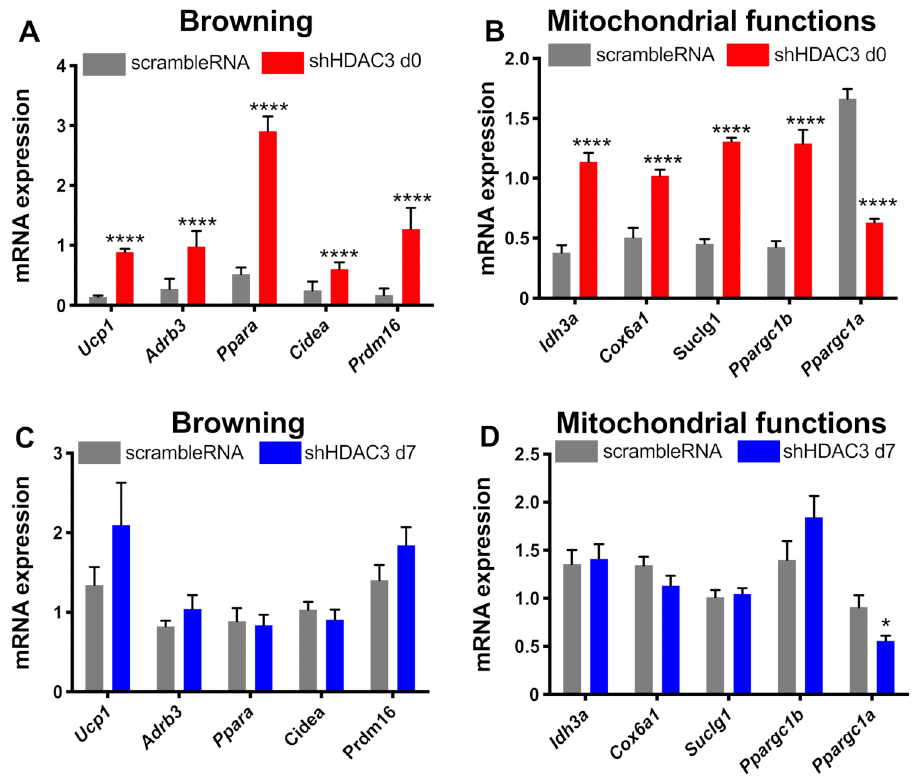
Figure 6. Expression of genes related to browning and mitochondrial functions. C3H/10T1/2 cells were infected with scramble/shHDAC3 at day 0 and expression of genes for browning ( A ) and mitochondrial functions ( B ) of differentiation to adipocytes. The expression of the same genes was measured in C3H/10T1/2 cells infected with scramble/shHDAC at day 7 ( C , D ). Cells silenced at day 0 were harvested at day 9 after induction of differentiation, while cells silenced at day 7 were harvested at day 11 after induction of differentiation. Data are presented as mean ± SEM. Statistical analyses were performed with GraphPad PRISM and unpaired Student’s t -test, **** p < 0.0001 ( n ≥ 8 from 3 independent